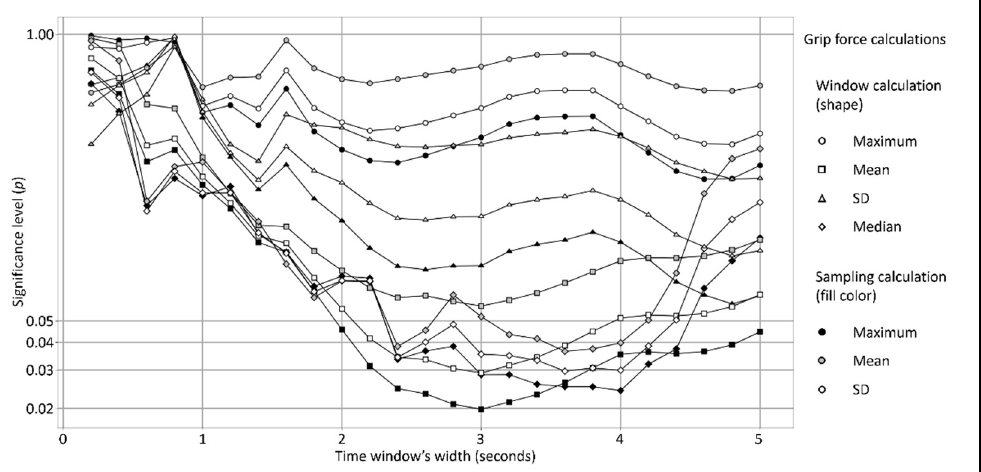
Figure 8. Significance level ( p ) of LMM analyses of grip force as a function of the crossing distance with the participant as the random effect, various time window widths, and no offset from the crossing event. X -axis expresses the width (0.2 to 5 s, 0.2 s increments), and Y -axis expresses the significance level ( p ), logarithmically scaled for representation. The shape type represents the window calculation (circle = maximum, square = mean, triangle = SD, rhombus = median), and the fill color represents the sampling calculation (black = maximum, grey = mean, white = SD).